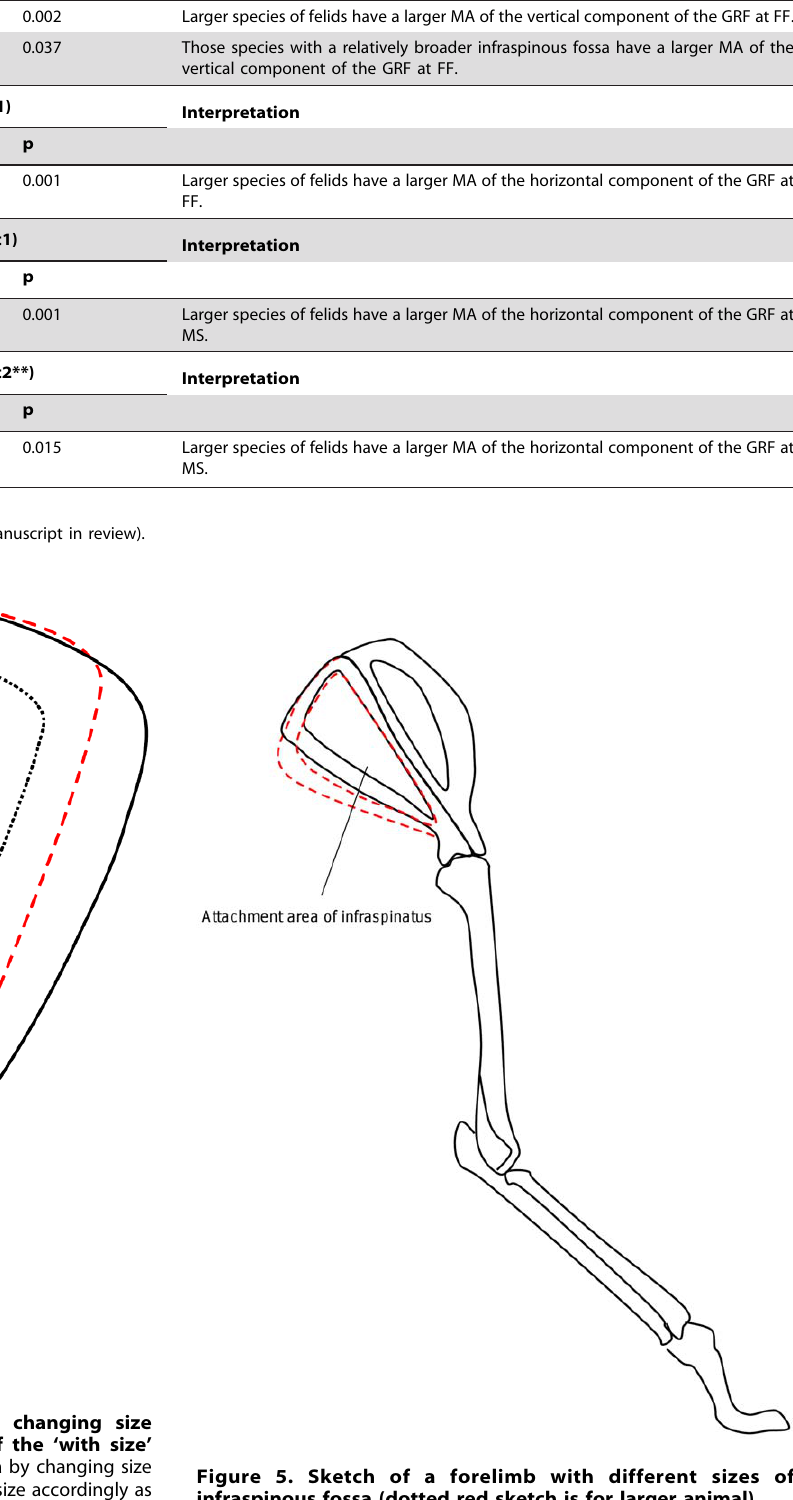
T 1 at FF (MAdataset1*)